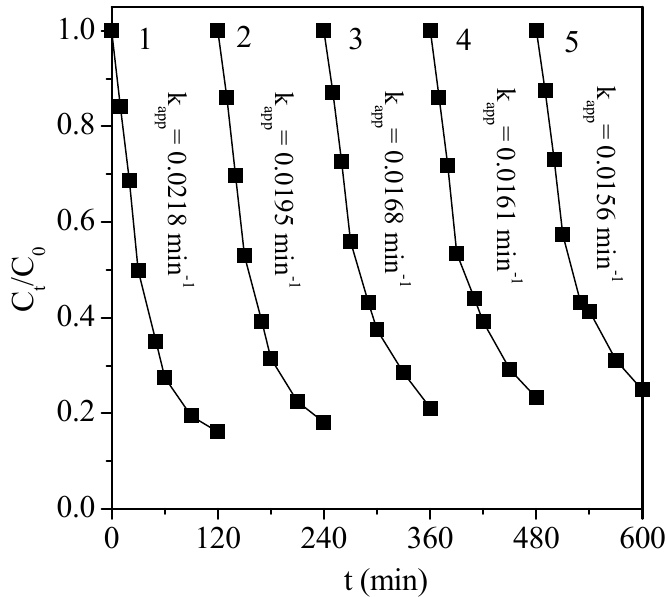
Figure 9. Evolution of the BA catalyst activity with the reaction cycles of TC degradation under visible light/PS/catalyst coupled process. Conditions: C 0 = 100 mg L − 1 , [PS] = 50 mmol L − 1 , [BA] = 0.5 g L − 1 , and pH 0 = 3.7.